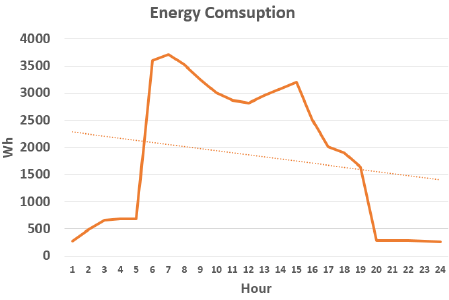
Figure 14. Energy consumption in office 4 of the first day of the mid-term evaluation.